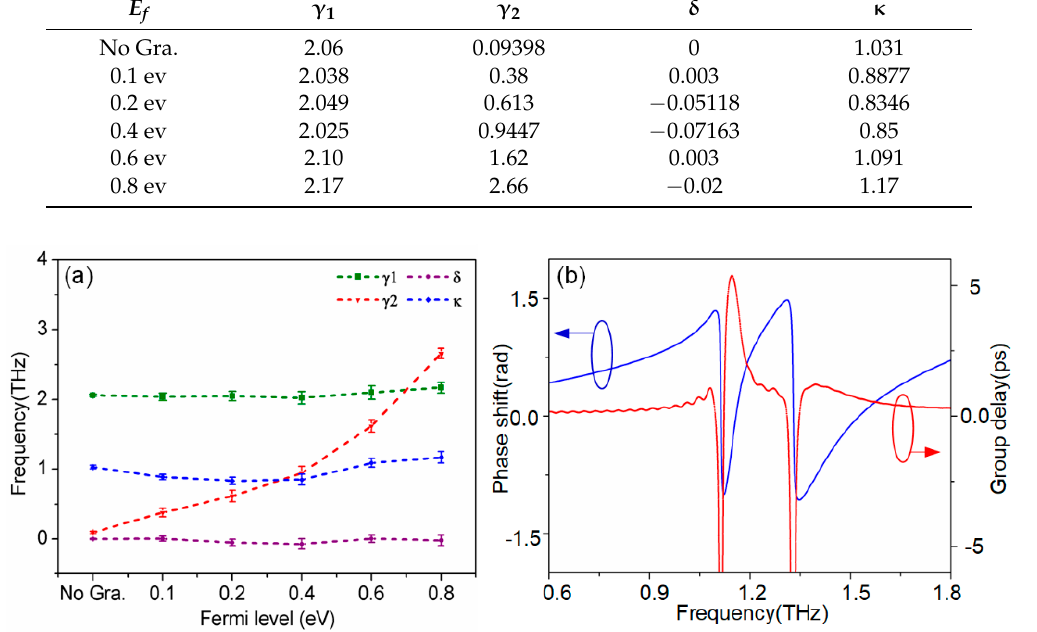
Figure 6. ( a ) Fitting parameters γ 1, γ 2, δ , and κ as a function of the Fermi level of graphene. ( b ) Transmission phase shift and group delay of the Al-based metamaterials without graphene.